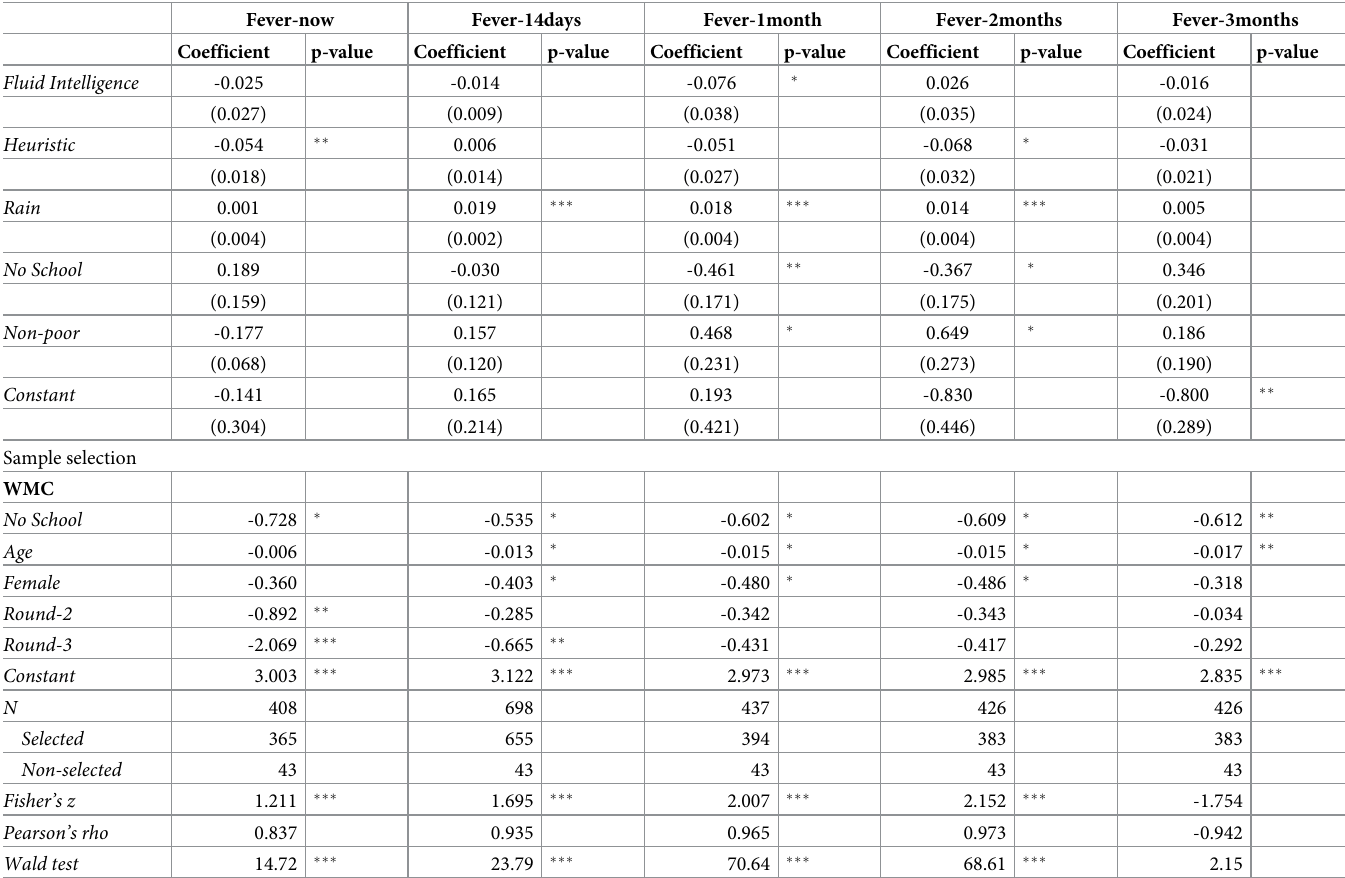
Table 3. Probit with sample selection (clustered by